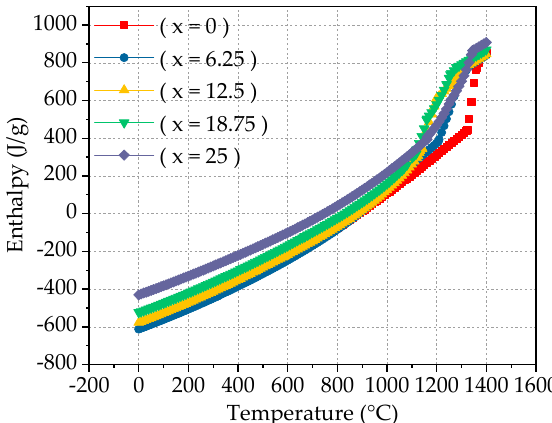
Figure 8. Enthalpy of mixing Δ H mix calculation for Fe 25 Cr 25 Ni 25 Ti x Al (25 − x) multi-principal element alloys.